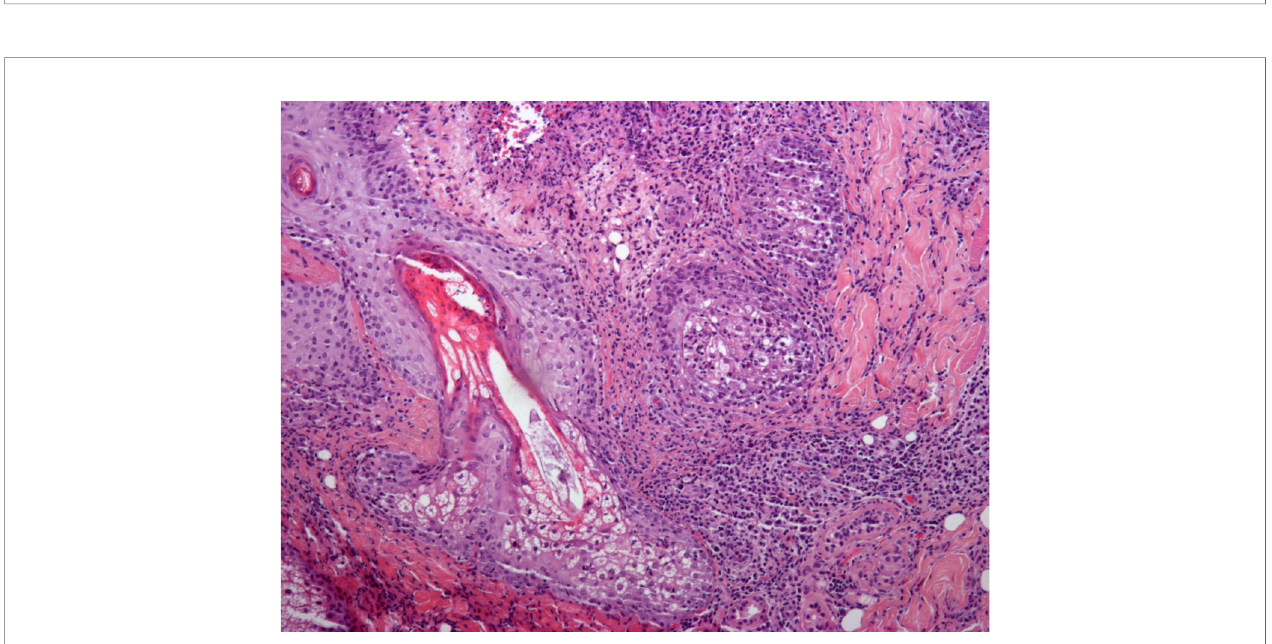
FIGURE 2 | Skin biopsy (hematoxylin and eosin staining, ×10). A mixed in fl ammatory in fi ltrate (arrow), without granuloma, related to pilosebaceous units, containing Demodex (star).